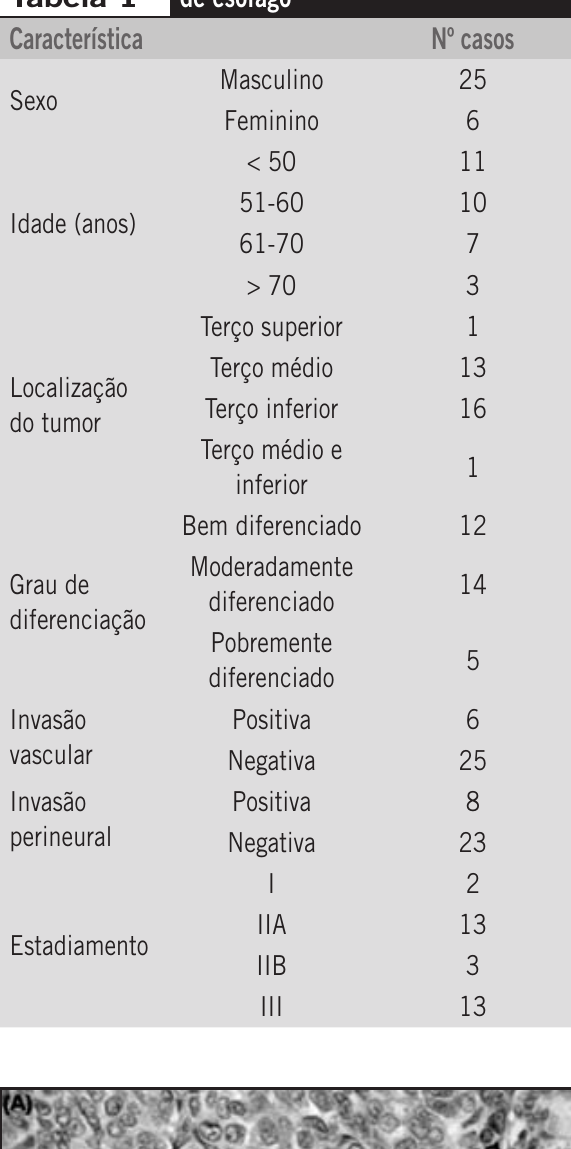
( Figura A ). Já a presença da MMP-9 pode ser claramente visualizada no citoplasma das células ( Figura B ). Dos 31 casos estudados, 25 (80,6%)